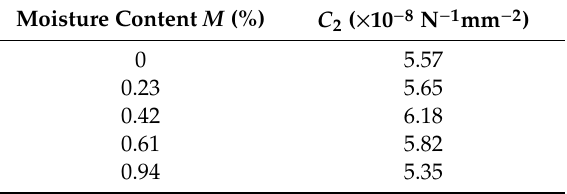
Figure 4. Distribution of mode II fracture toughness with moisture content level. Table 1. Compliance constant at different moisture content levels